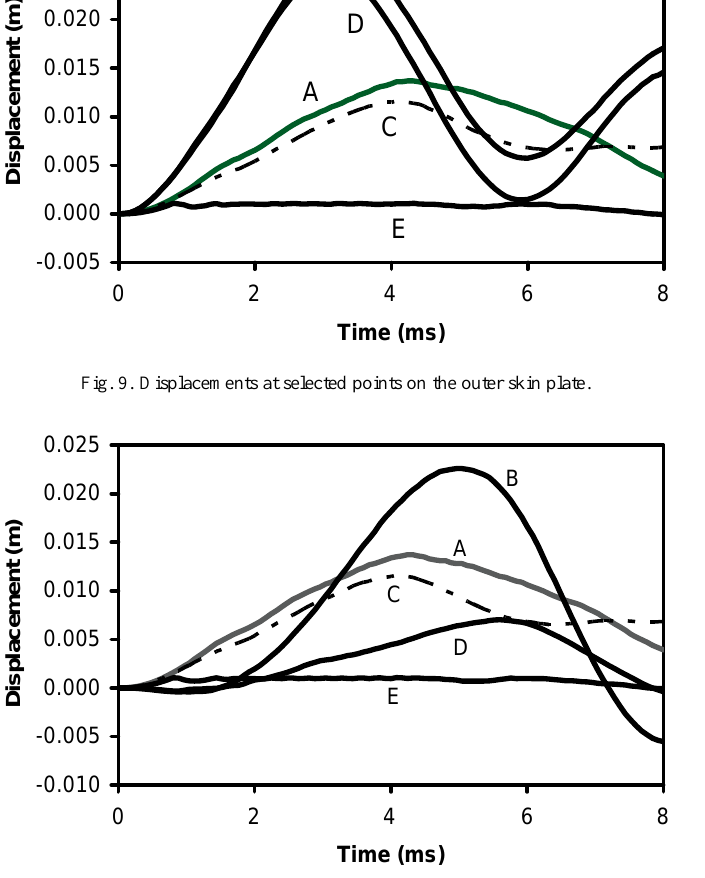
the explicit approach is found to be about twenty times more efficient than the implicit approach to achieve roughly the same